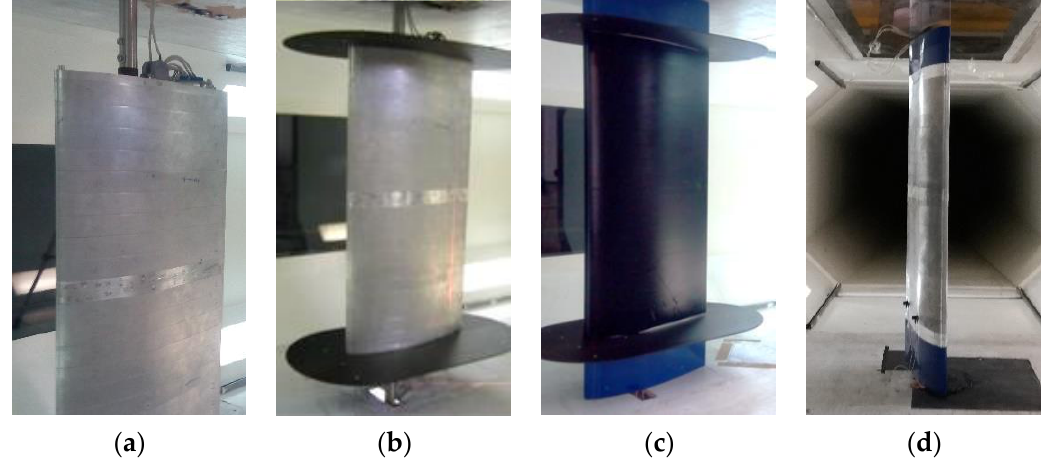
Figure 2. Wing model configurations.